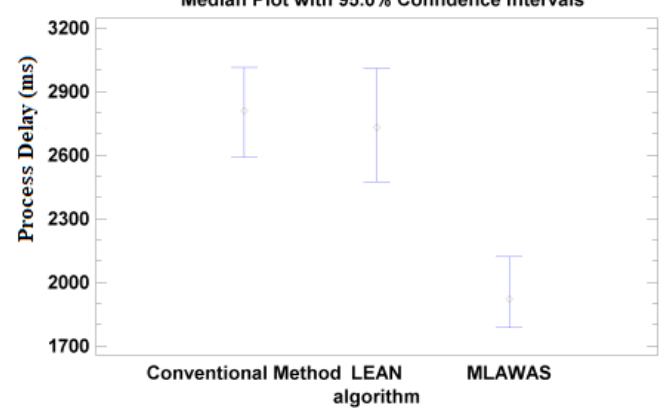
Figure 11. Processing Delay of Workload.